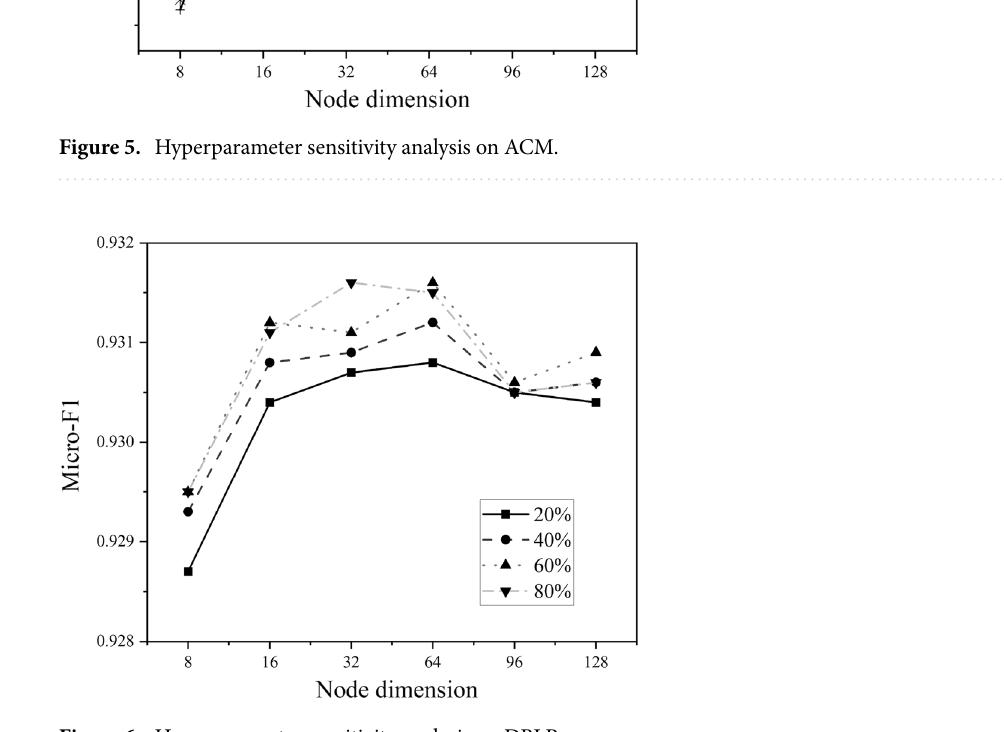
Figure 6. Hyperparameter sensitivity analysis on